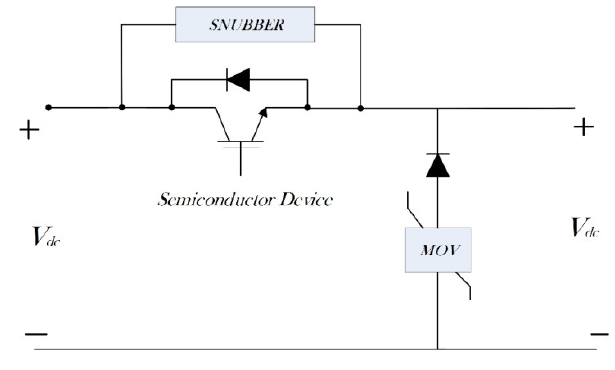
Figure 13. General configuration of SSCB [79].